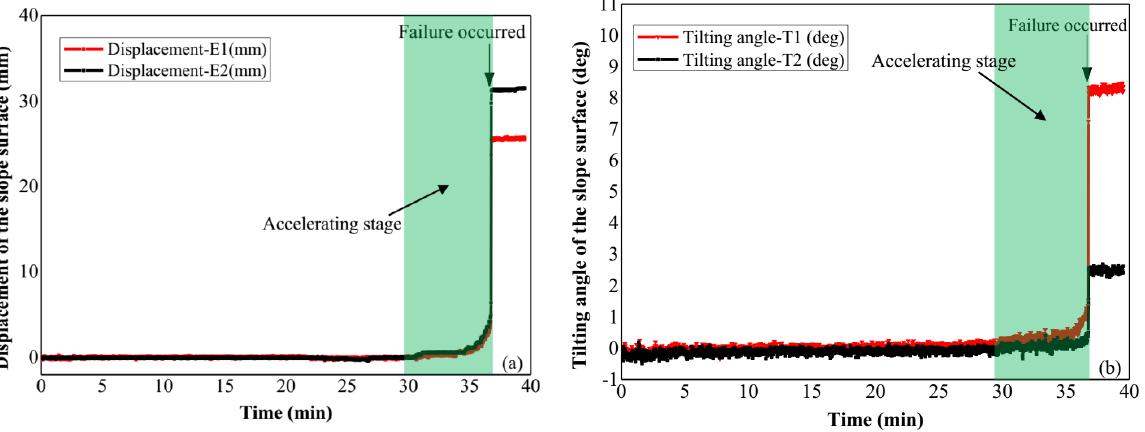
Figure 6. ( a ) Time history of the displacement at the slope surface in Model Test 1, ( b ) time series of the tilting angle at the slope surface.